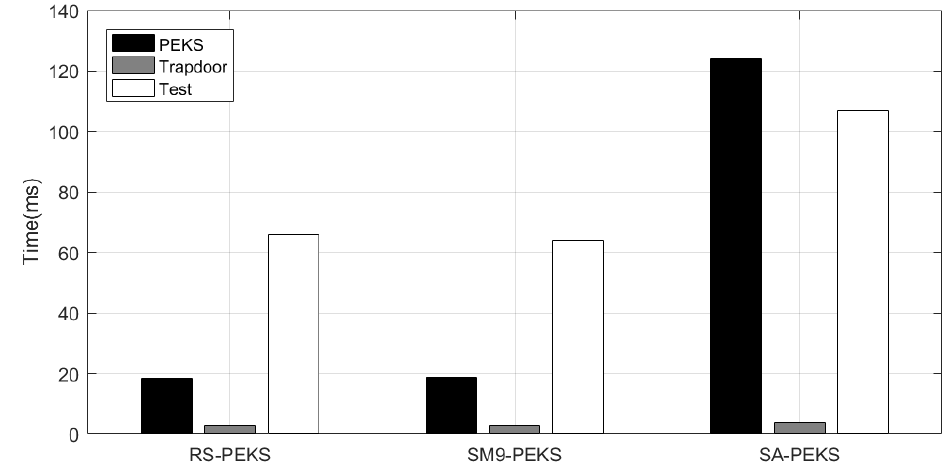
Figure 7. Comparing the average time of each